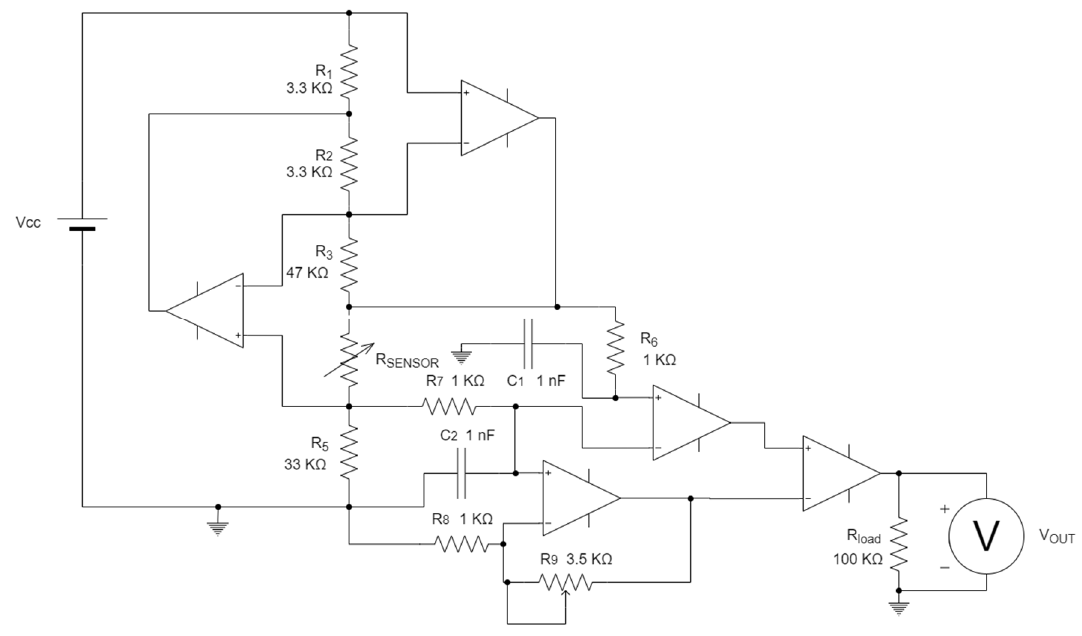
Figure 4. Electronic system based on the Anderson loop.